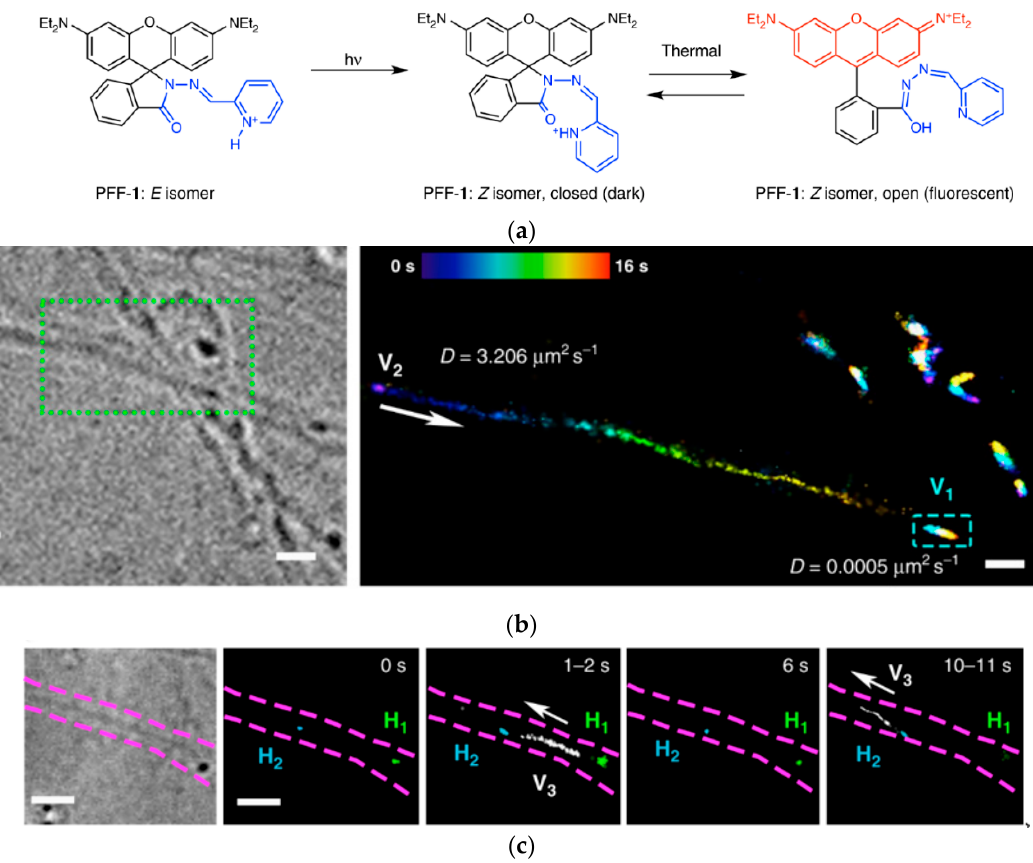
Figure 22. Fluxional fluorophores for less photobleaching: ( a ) Mechanism of photoactivation and fluxionality of PFF-1 ; ( b ) Bright-field image of a neuronal projection and synapse and an image reconstructed from all frames collected during a 16 s acquisition within the green ticked area, as well as the diffusion coefficients of two vesicles (V1 and V2); ( c ) Bright-field image and fast diffusion of an acidic vesicle (V3) between hotspots (H1 and H2) in 20 s of a single neuronal projection. Adapted with permission of [267]. Scale bars = 2 µm ( b ) and 1 µm ( c ).